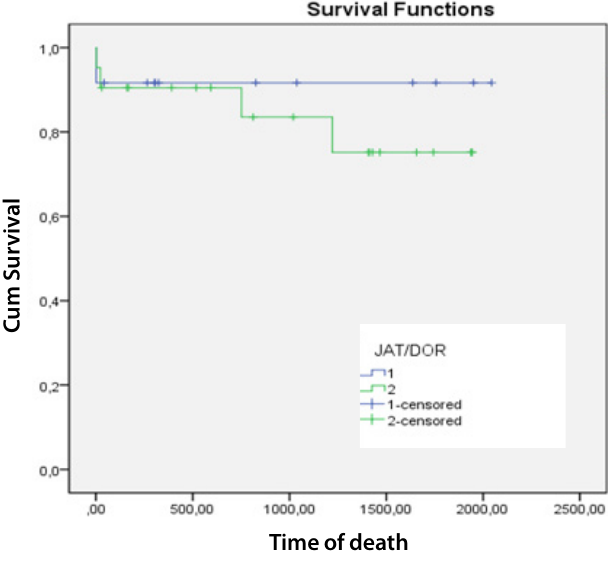
Fig. 1 – Survival of patients according to type of ventricular